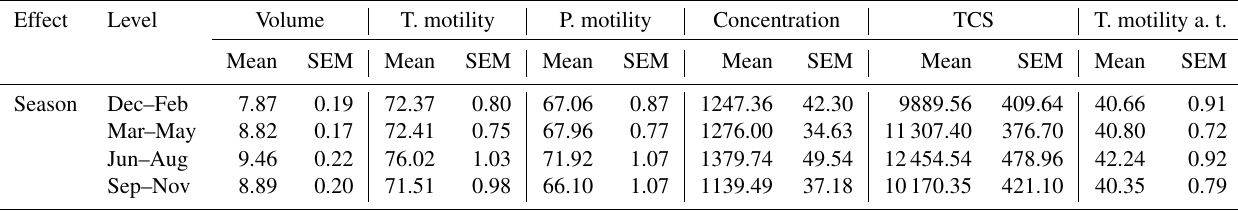
Table 4. Means and standard error of the means of dependent variables according to different season classes. Effect Level